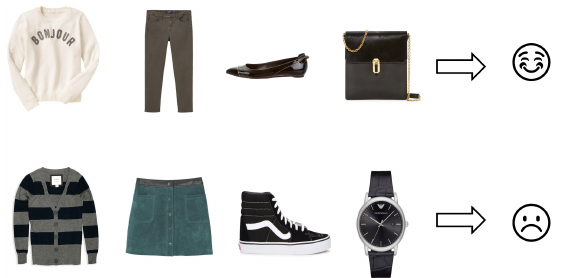
Figure 1. Example compatible and incompatible